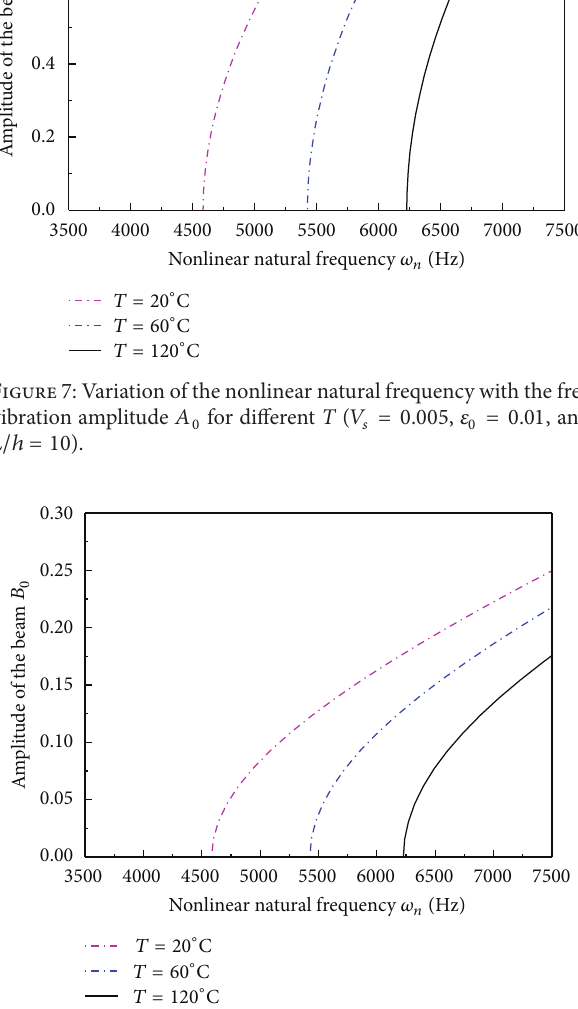
Figure 8: Variation of the nonlinear natural frequency with the free vibration amplitude 𝐵 0 for different T ( 𝑉 𝑠 = 0.005 , 𝜀 0 = 0.01 , and 𝐿/ℎ = 10 ).